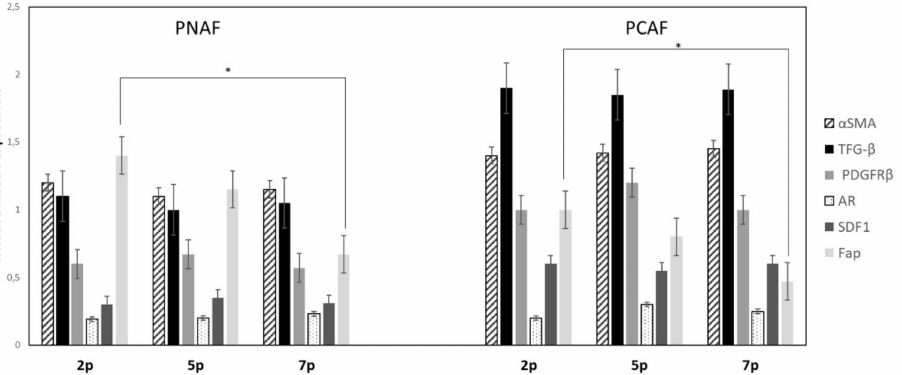
Figure 6. CAF-related gene expression during cell culturing. Expression of α SMA, TGFb, PDGFRb, AR, SDF1, and FAP on total RNA isolated from PCAFs and PNAFs during culture conditions from passage 2 to passage 5 and 7 was evaluated by RT-qPCR. The values shown are the 2 − ∆∆ Ct ratios of the difference between cycle thresholds ( ∆ Ct) of the corresponding marker genes and the housekeeping gene GAPDH; n = 3 independent differentiation experiments * p ≤